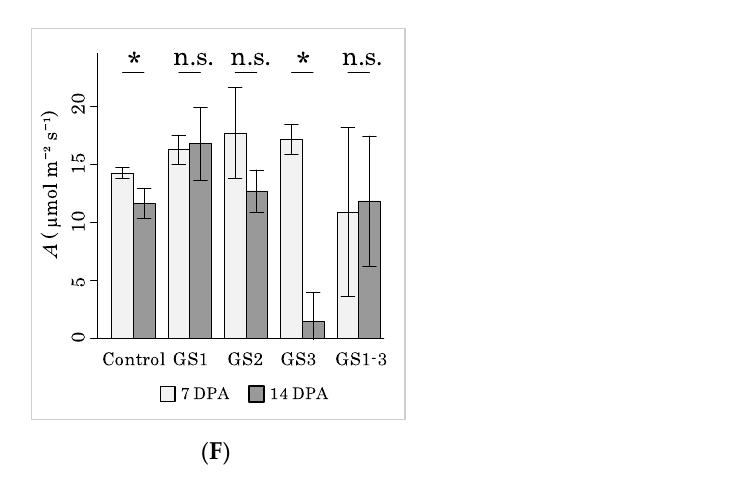
Figure 7. Photosynthetic rate measured at 14 DPA. ( A ) A–C i curve; ( B ) carbon assimilation rate, ( C ) TPU , ( D ) J , and ( E ) Vcmax at 400 ppm CO 2 ; ( F ) A at 400 ppm CO 2 at 7 and 14 DPA (* p = 0.01). n = 3. Bars with the same letters in B – F are not significantly different by Tukey’s range test ( p < 0.05).